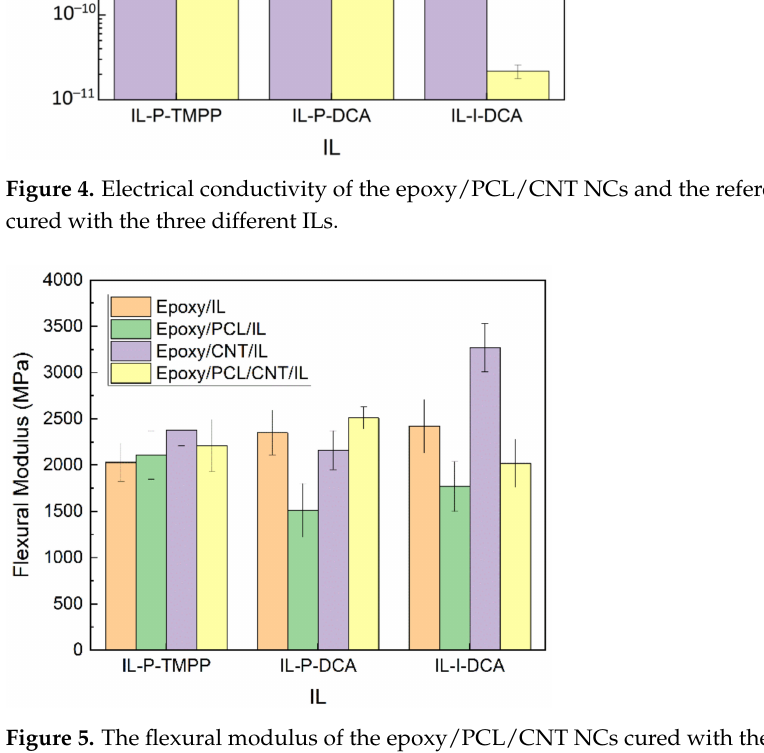
Figure 5. The flexural modulus of the epoxy/PCL/CNT NCs cured with the three different ILs, as well as that of the reference epoxy/IL, epoxy/PCL/IL and epoxy/CNT/IL systems.